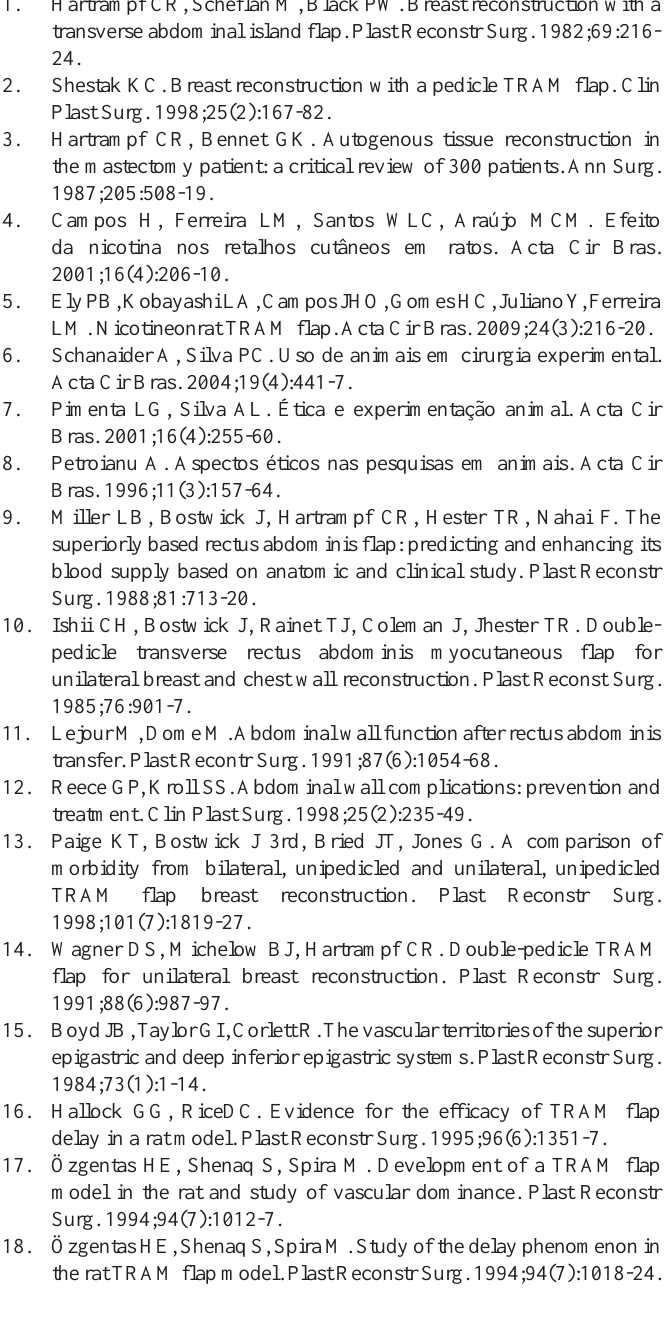
19. Lopes Filho R, Lázaro da Silva A. Efeito das técnicas operatórias de autonomização no retalho musculocutâneo transverso do músculo reto do abdome. Estudo experimental em ratas. Rev Soc Bras